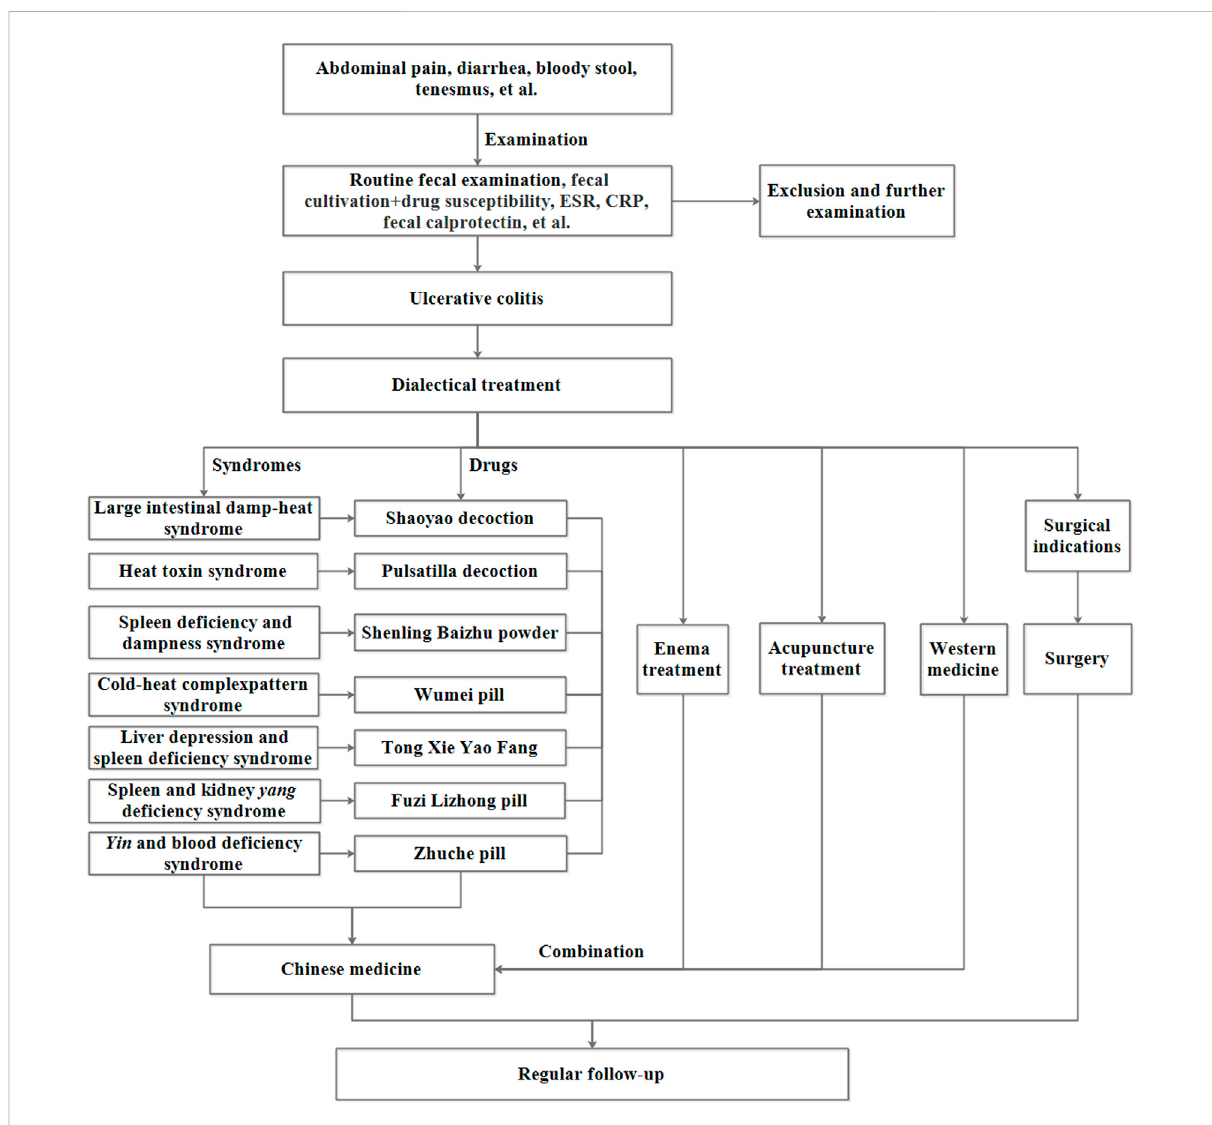
FIGURE 1 The processes of diagnosis and treatment of